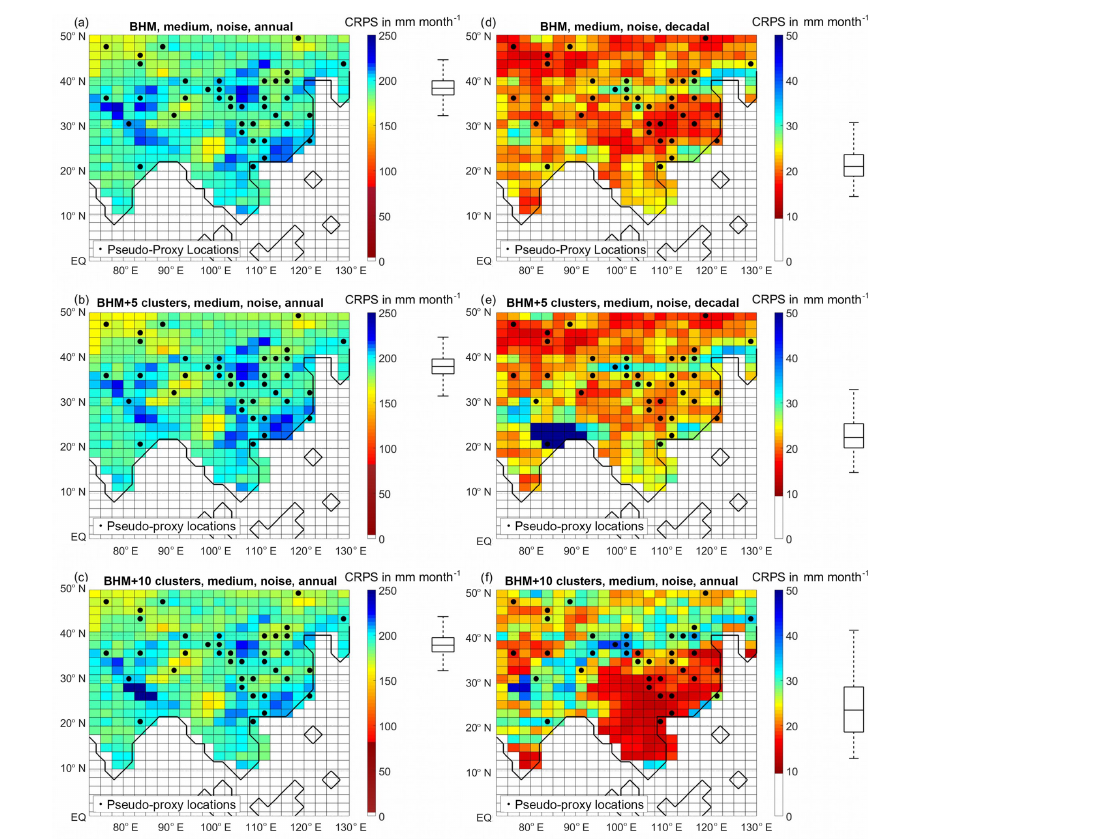
Figure 6. CRPS for different reconstructions, at each grid point. (a, b, c) Annually resolved data. (d, e, f) Decadally resolved data. (a, d) BHM reconstruction. (b, e) BHM + 5Clusters. (c, f) BHM + 10Clusters. The boxplots (indicating median, 25% and 75% percentiles and non-outlier limits) to the right of the colour bars show the distribution of the grid-point CRPS. Black dots: pseudo-proxy